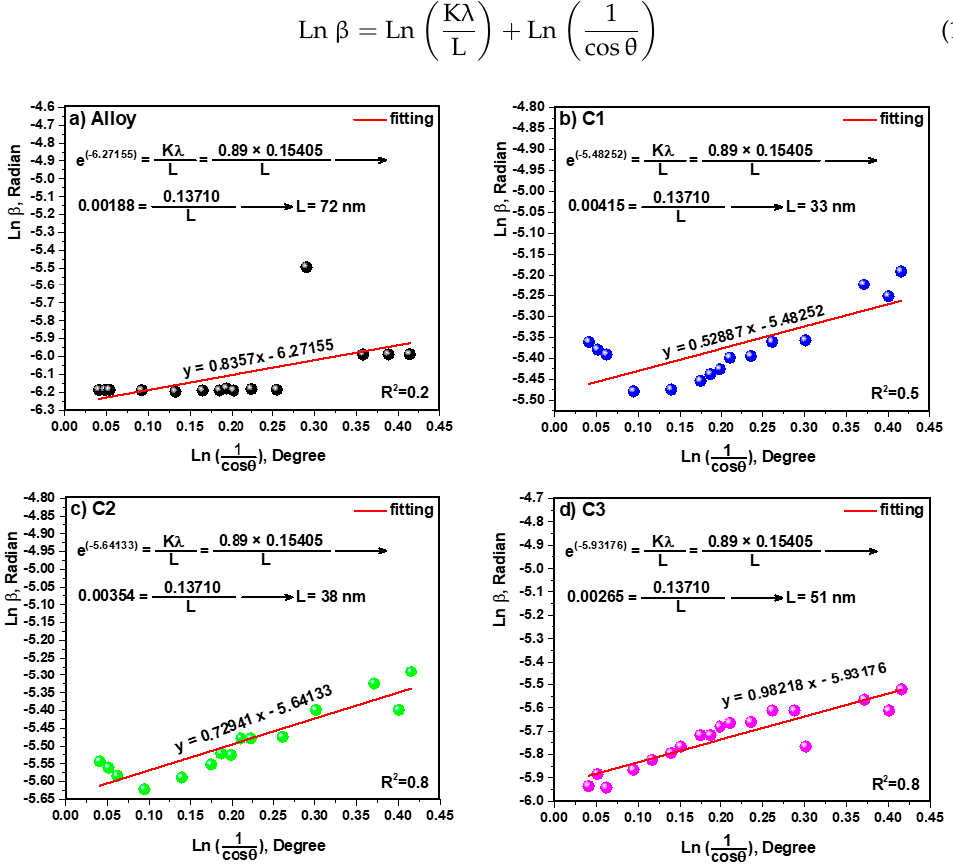
Figure 5. Linear plots of Monshi–Scherrer equation and calculated crystallite size of ( a ) Alloy, ( b ) C1, ( c ) C2 and ( d ) C3. ( c ) C2 and ( d )